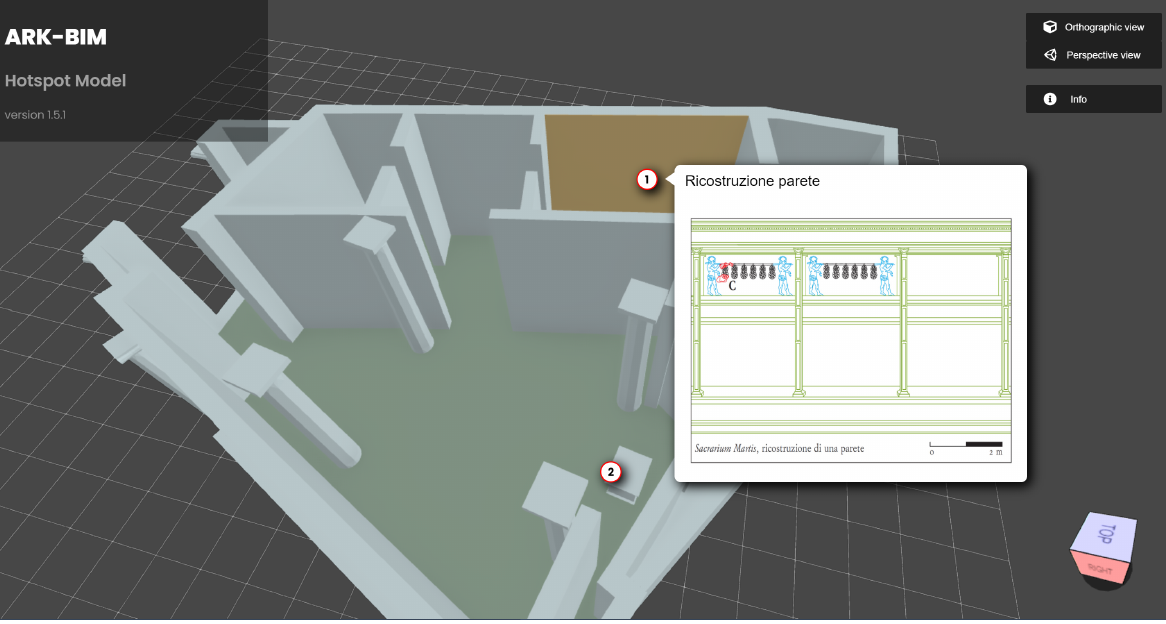
Figure 16. ARK-BIM (version 1.5.1): Hotspot Model plugin, sample with textual information. As mentioned before, the XEOKIT toolkit was also utilized for developing the Meas- urements Centre plugin. This was designed for picking distances and angles directly on the model (Figures 17–19). A button enables unlocking the measurement process via left click- ing on desired distances on the model; the plugin will display a projection of X, Y, Z dis- tances, the default view is in meters and units of measurement can be easily scaled. Hence, the measurement centre has also been implemented with another important tool for pick- ing precise measurements of angles on the model. This plugin has been included, as shown by XEOLABS developers. However, distances and angles have been enabled via dedicated buttons, thus avoiding refreshing the page each time. Thanks to the inclusion of JavaScript Controller Library, distances can then be picked by using different units and scales. This library implementation is now the basis for further development for enriching the Measurements Centre plugin. Finally, the orthographic projection switch was included (perspective and ortho view).